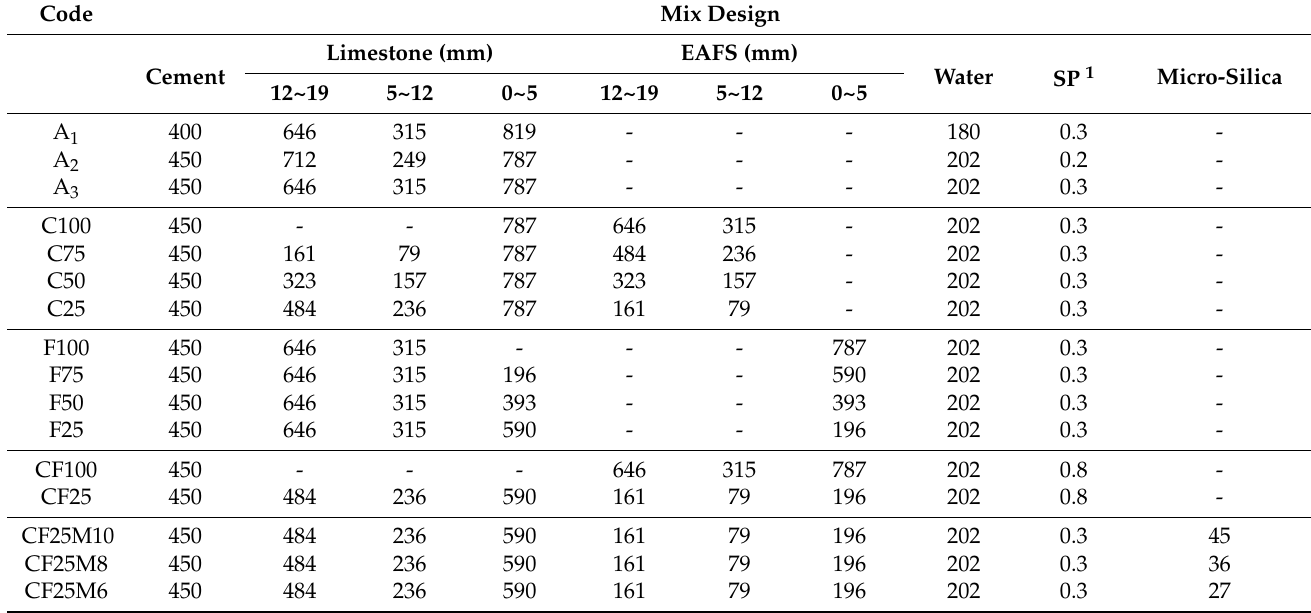
Table 7. Mix design used for this study (kg/m 3